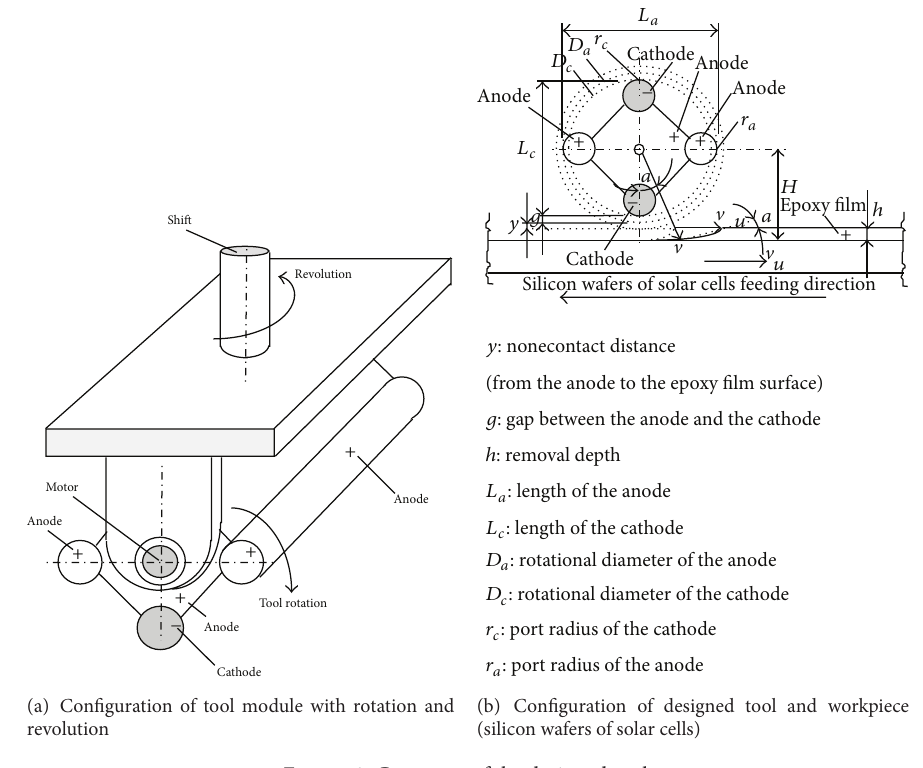
Figure 3: Geometry of the designed